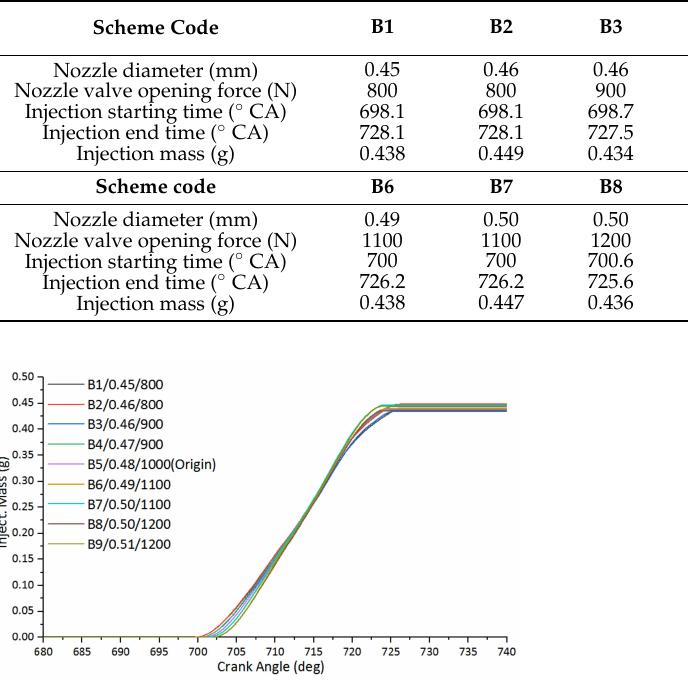
Figure 25. Cumulative fuel injection mass per cycle for Pre-selection